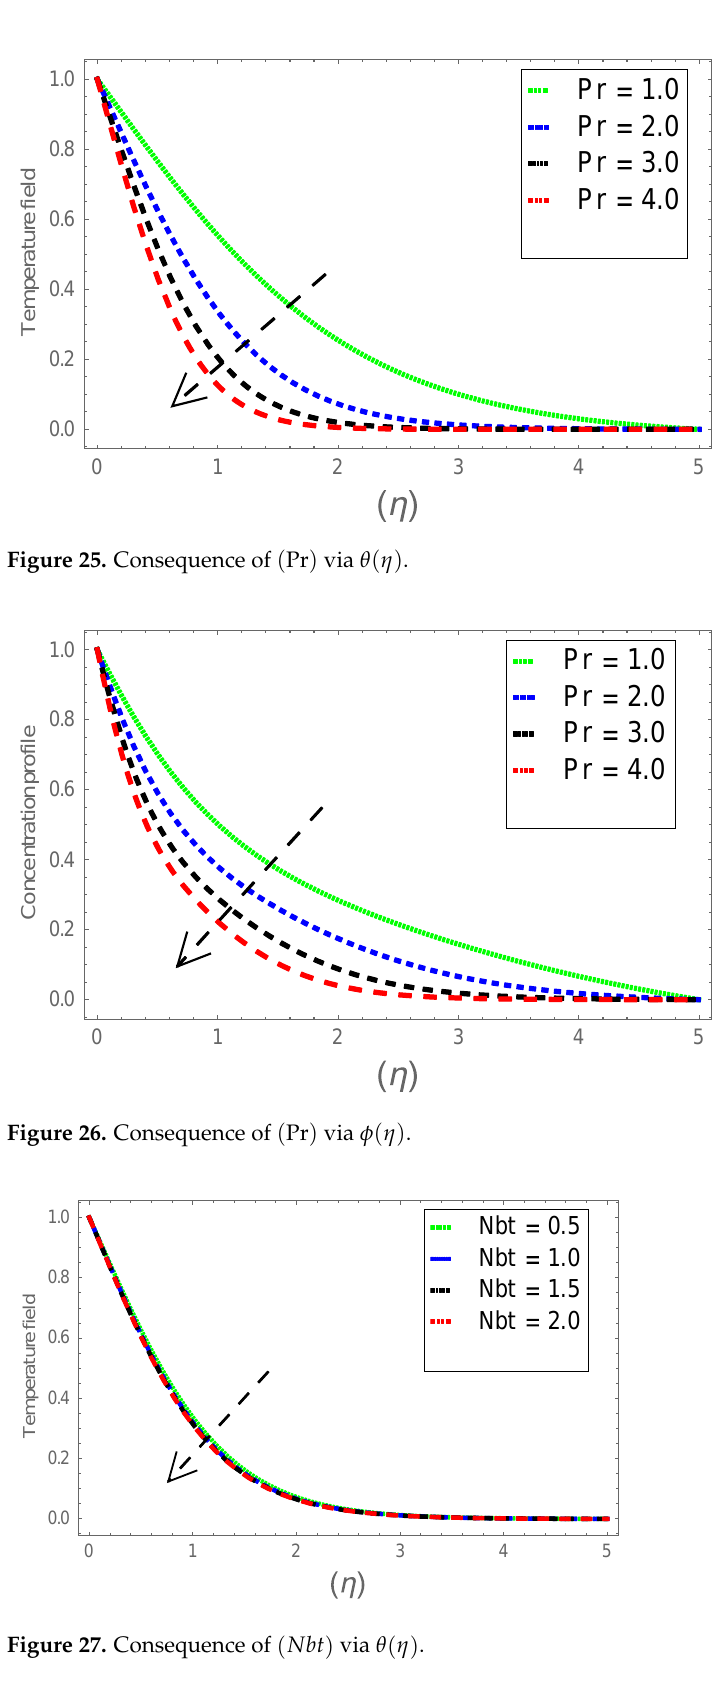
Figure 27. Consequence of ( Nbt ) via θ ( η )